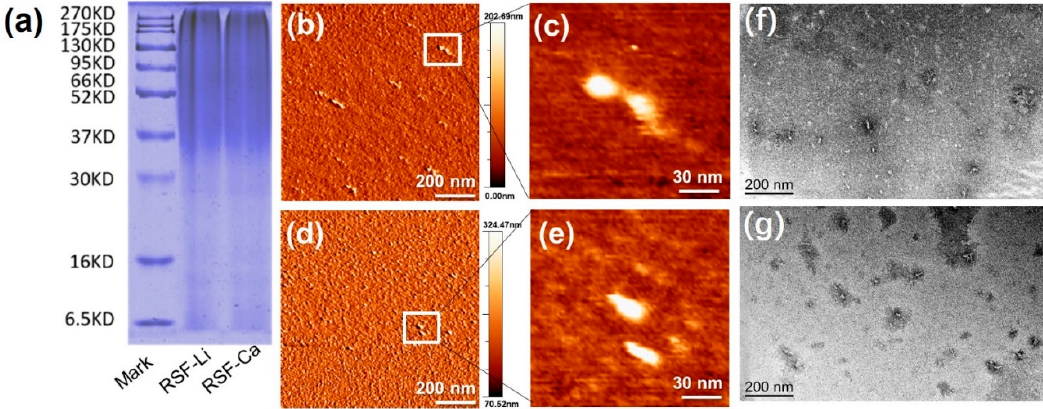
Figure 1. Molecular weight and morphology of the RSF. ( a ) The SDS-PAGE result. ( b – e ) The AFM images of the RSF-Ca ( b , c ) and the RSF-Li ( d , e ) in solution. ( f , g ) The TEM images of the RSF-Ca ( f ) and the RSF-Li ( g ). The arrows ( e , f ) indicate the